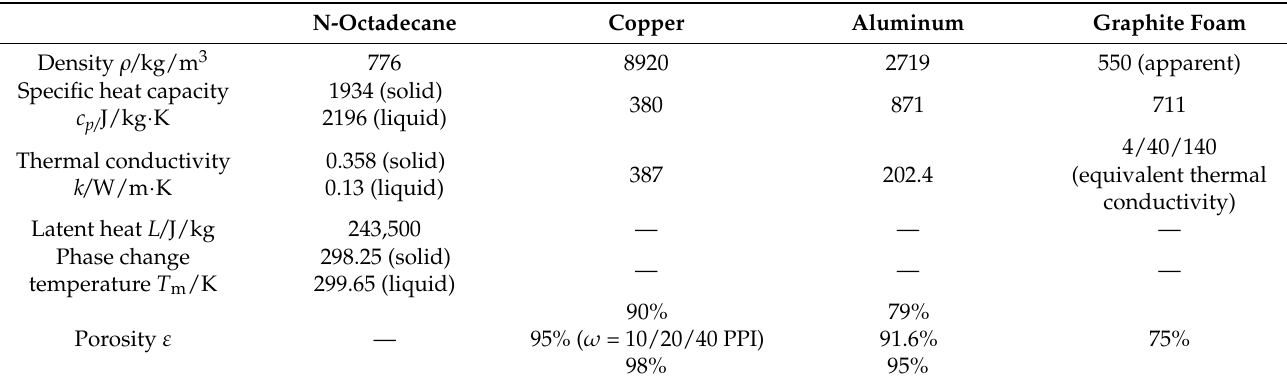
Table 1. Thermal properties of materials